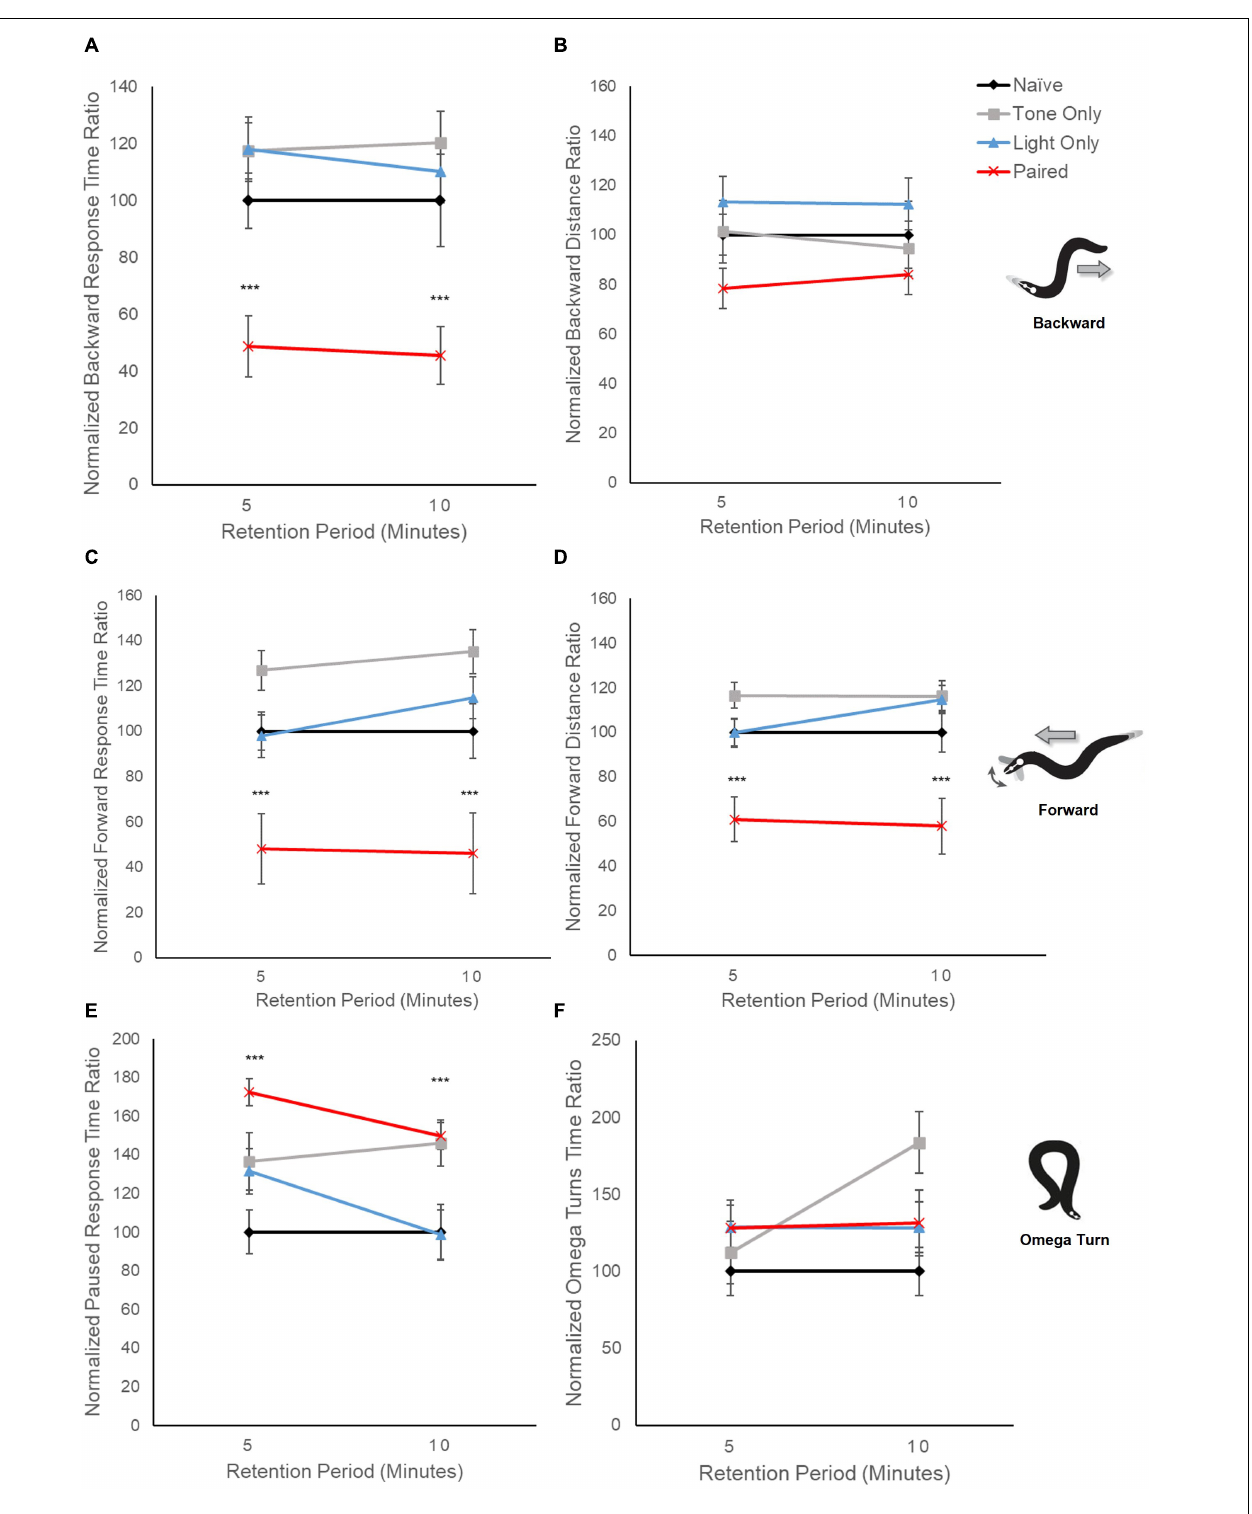
FIGURE 3 | Locomotion metrics indicate differences in locomotor response circuits following conditioning. Graphs display averaged response metrics for a period of 60 s following a 5-s tone stimulus delivered at 5 min and 10 min after conditioning (retention period). Average response metrics of all training groups are expressed relative to the average of Naïve worm responses. Mean ( ± SEM) for: (A) backward response time ratio, (B) backward distance ratio, (C) forward time ratio, (D) forward distance ratio, (E) paused time ratio, and (F) omega turn time ratio. *** p < 0.001 between Naïve and Paired groups. Worm movement illustrations adapted with permission from Broekmans et al.